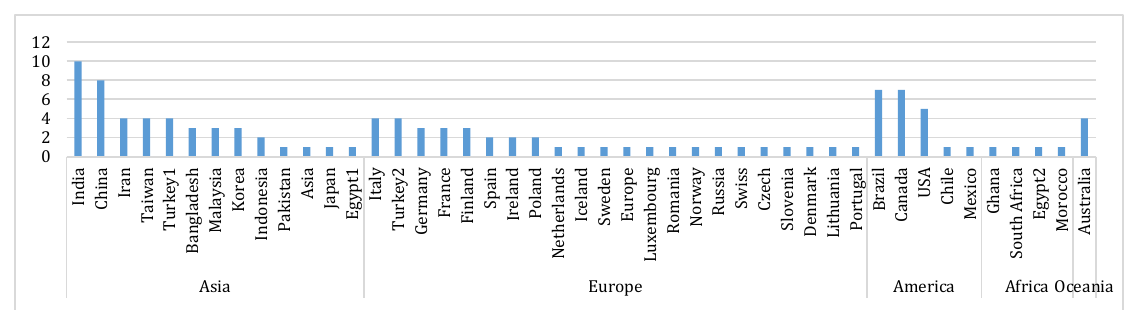
Figure 5: Distribution by